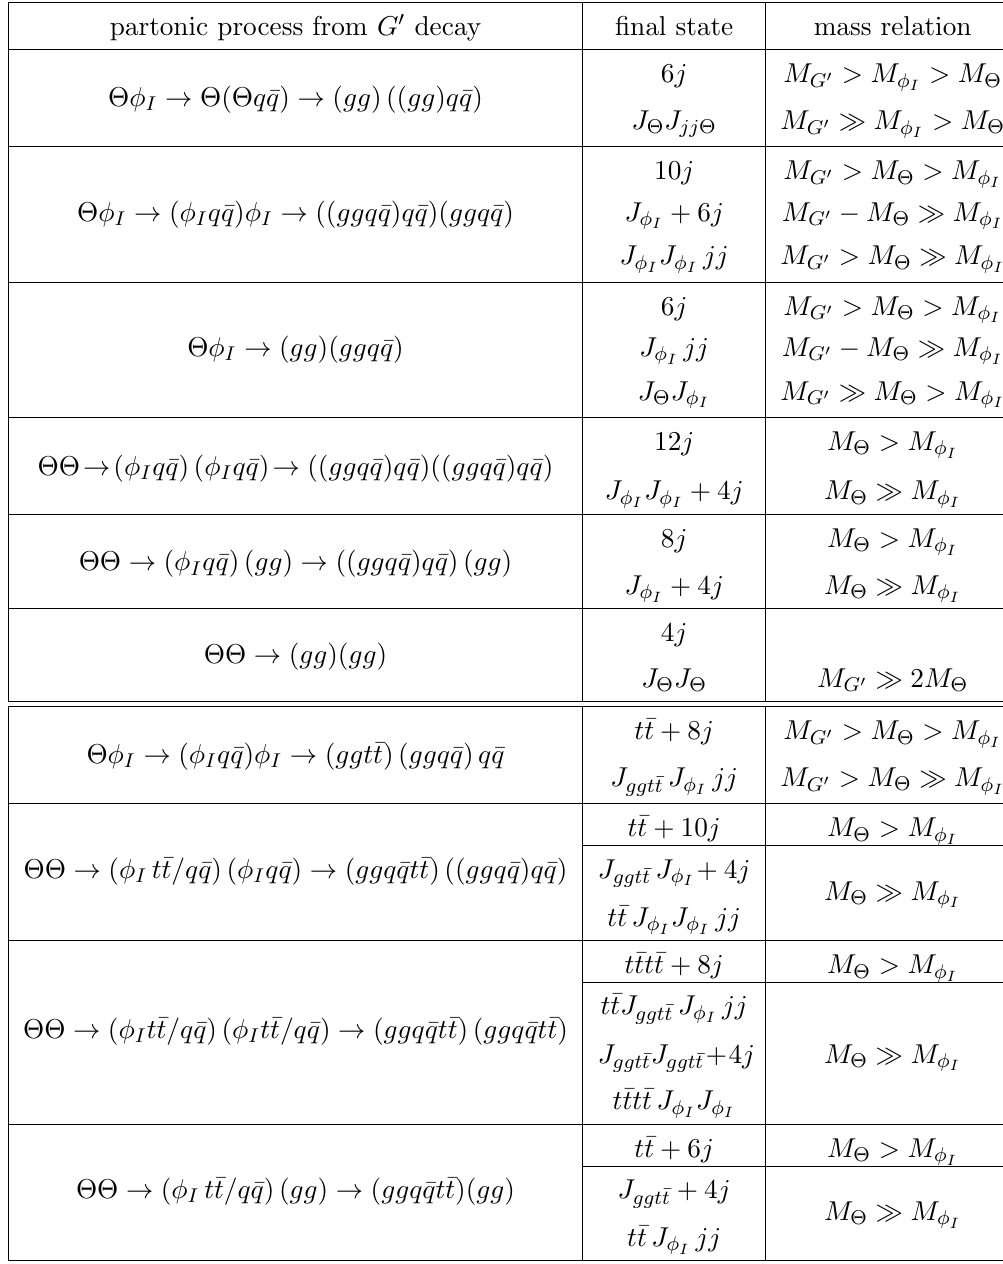
Table 1 . Main LHC processes predicted in the ReCoM when M (cid:30) I > M (cid:2) , or when M (cid:30) I < M (cid:2) with (cid:30) I decaying to ggq (cid:22) q . Each parenthesis represents a resonance. J (cid:30) is a jet with 4-prong substructure I arising from a boosted (cid:30) I ggq (cid:22) q , and J is a boosted (cid:30) I ggt (cid:22) t . Depending on the parameters ggt (cid:22) t ! ! . 1 TeV. J from eq. (4.5), J (cid:30) and J may have a displaced vertex for M (cid:30) (cid:2) is a jet with ggt (cid:22) t I I